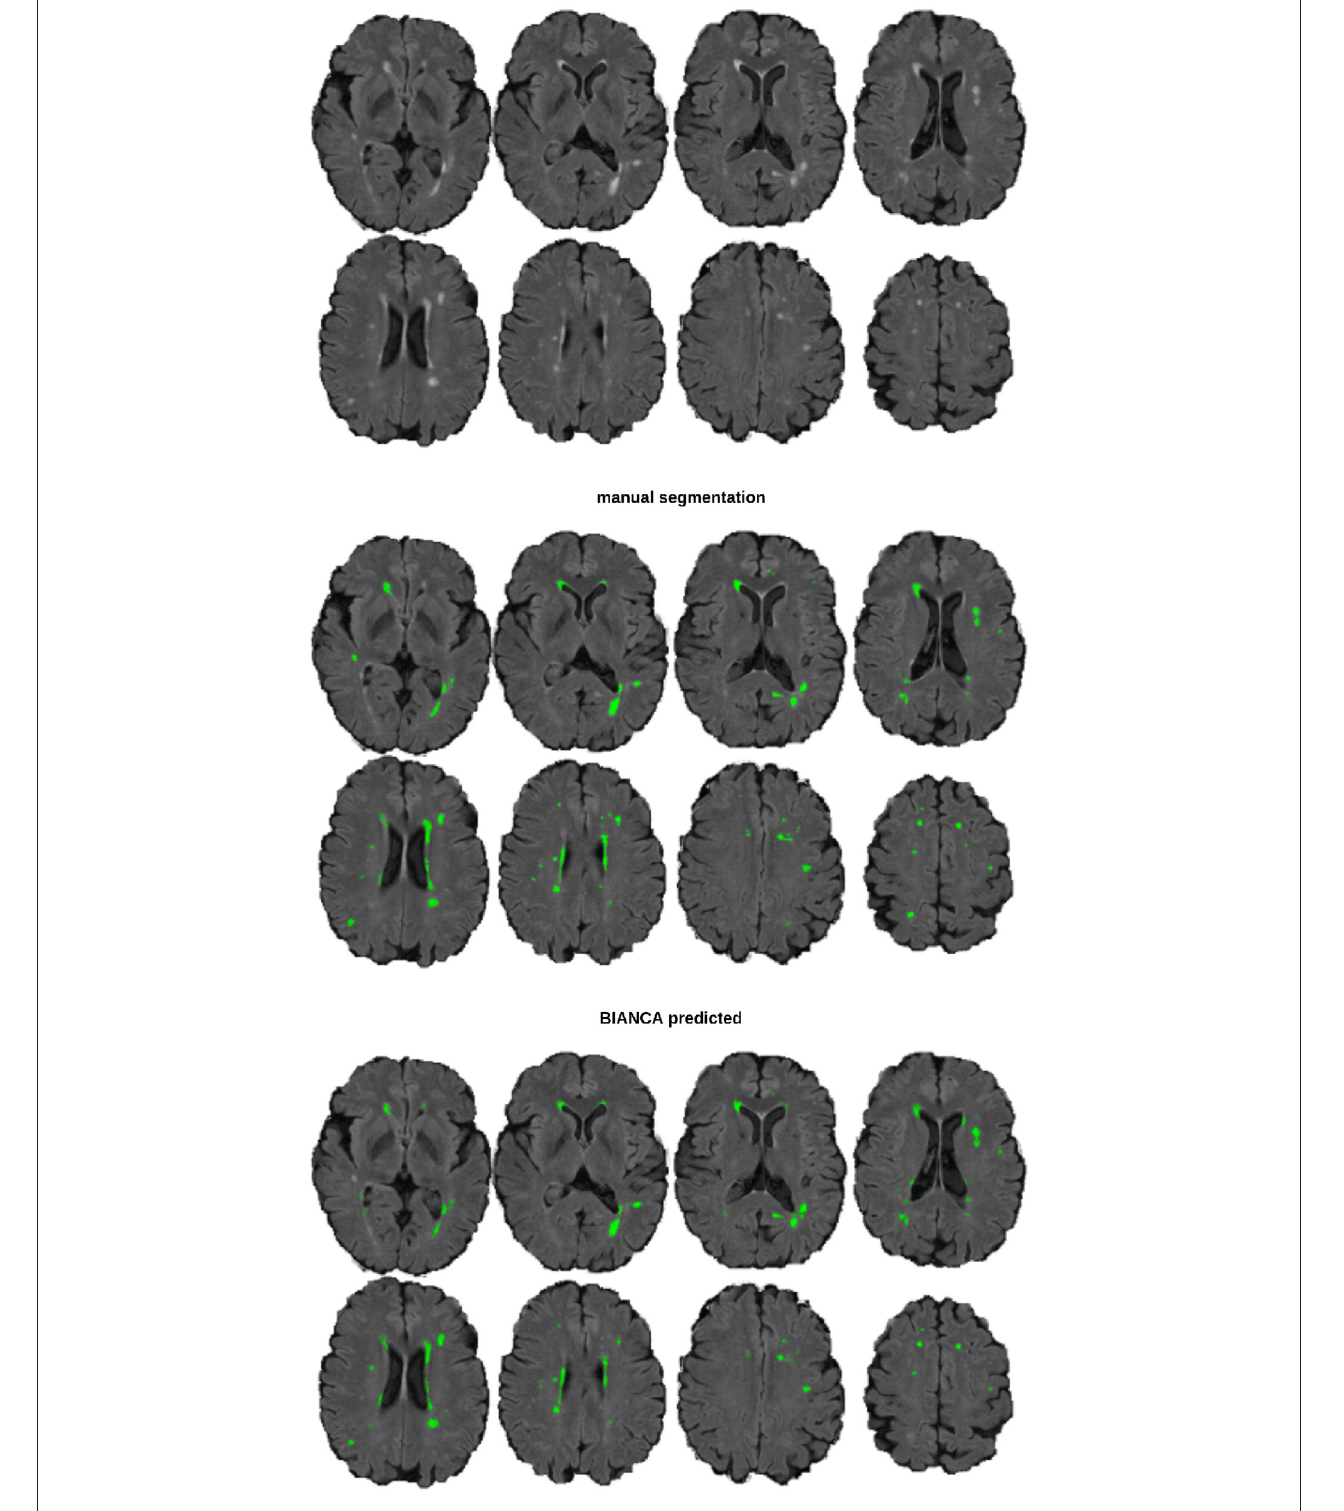
FIGURE 1 | An example image of a participant with 5 ml WMH volume The top section shows the underlying FLAIR image, the middle section the manual segmentation mask, and the bottom section the BIANCA predicted mask (threshold: 0.8), from a model trained with a sample size of n = 40.